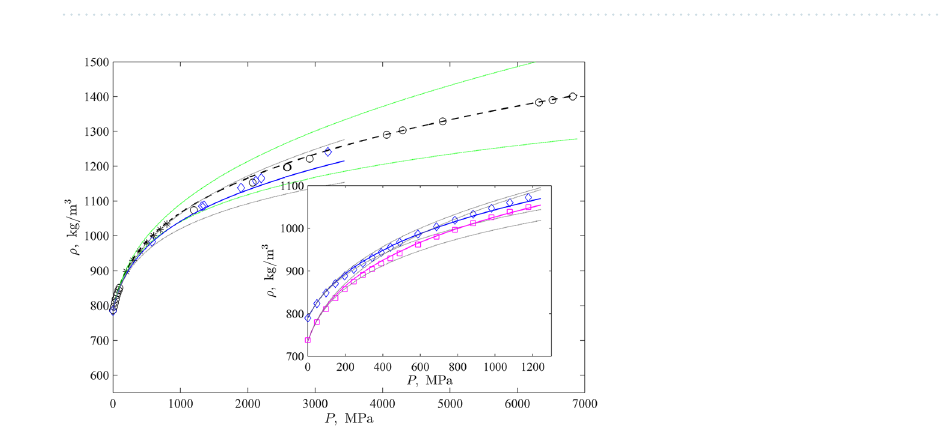
Figure 1. Experimental vs. predicted densities of liquids listed in Table 1 for the case of rounded isothermal nonlinearity parameters ( A ) and their relative deviations as a function of the pressure ( B ). Different colours correspond to different liquids; circles and crosses denote data for isotherms located below and above the normal boiling point.